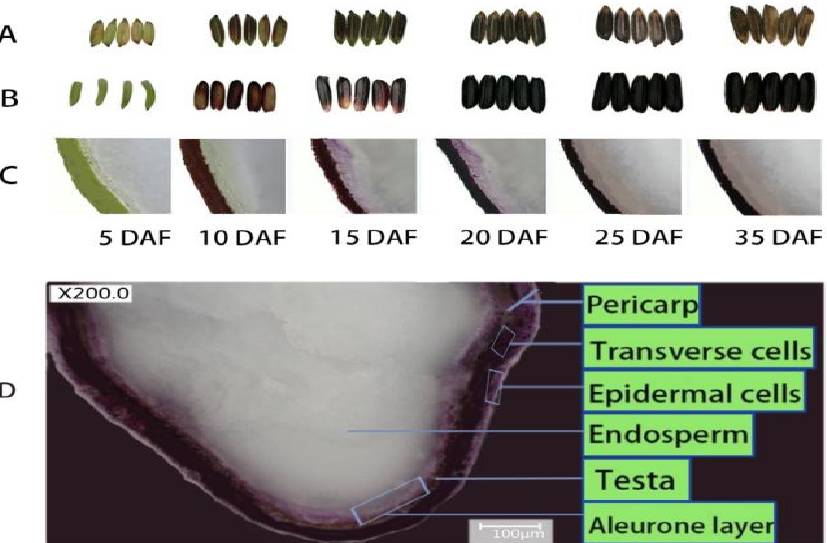
Figure 3. Different changes in caryopsis pigmentation during grain development in black rice. ( A ) Change in hull pigmentation of rice grain; ( B ) Evolution in caryopsis pigmentation at different developmental stage; ( C ) Longitudinal sections of caryopsis at different stages of development; ( D ) Caryopsis cross-section and super depth three-dimensional (3D) microscopic system imaging showing the pericarp, aleurone layer, and